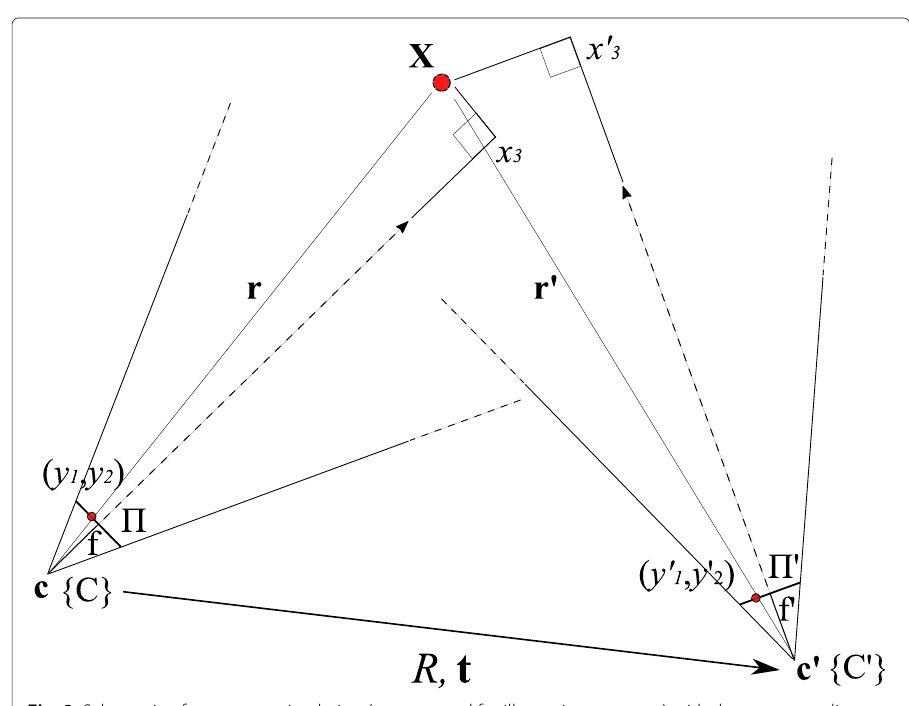
Fig. 2 Schematic of a camera pair relation (exaggerated for illustrative purposes) with the corresponding projection of the world point X onto the respective image planes (cid:2) , (cid:2) (cid:3) . The relative rotation R and translation t are known from calibration. The smaller R and t , the better the co-aligment between both cameras, making the overlay of their respective images possible